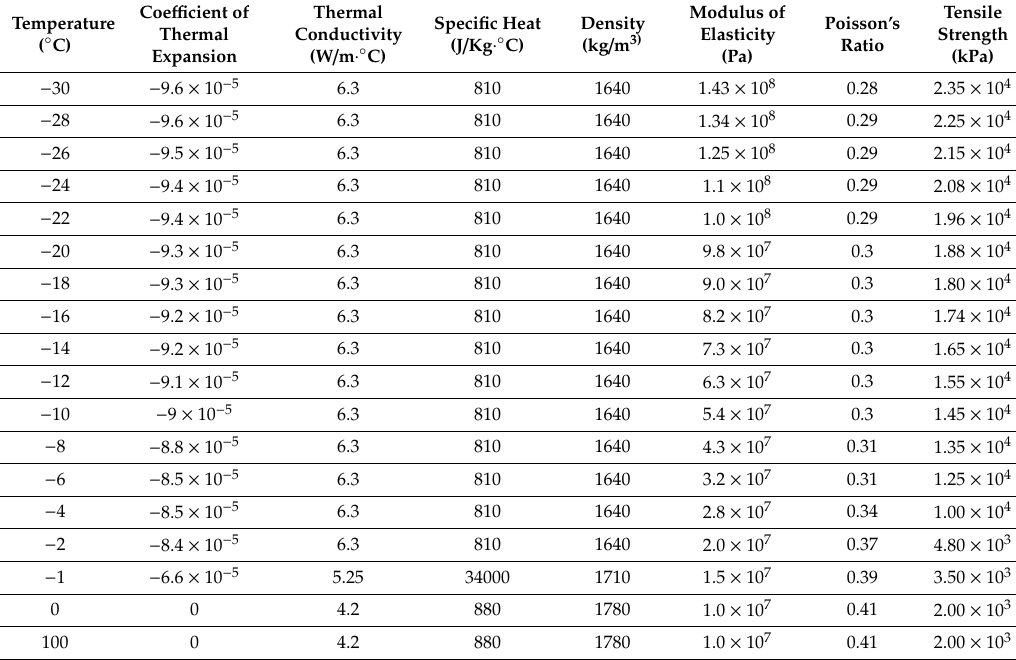
Table 1. Thermal physical and mechanical parameters of the soil.